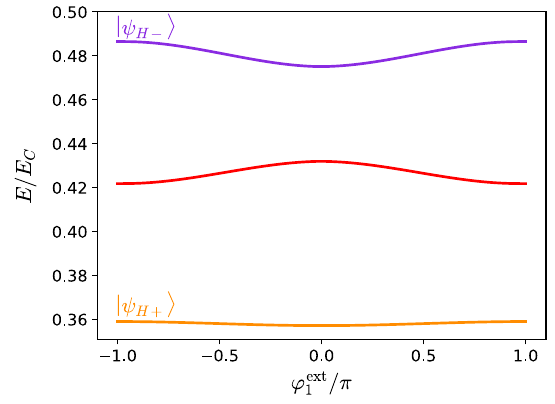
FIG. 12. Low-energy spectrum of the circuit shown in Fig. 10 as a function of the external flux φ ext 1 ¼ 2 π Φ ext 1 = Φ 0 for the ;s parameters in Table II and with the other external fluxes set to zero. For these values, j ψ is the second excited state. One H − i can clearly notice the sweet spots when φ ext 1 is an integer multiple of π